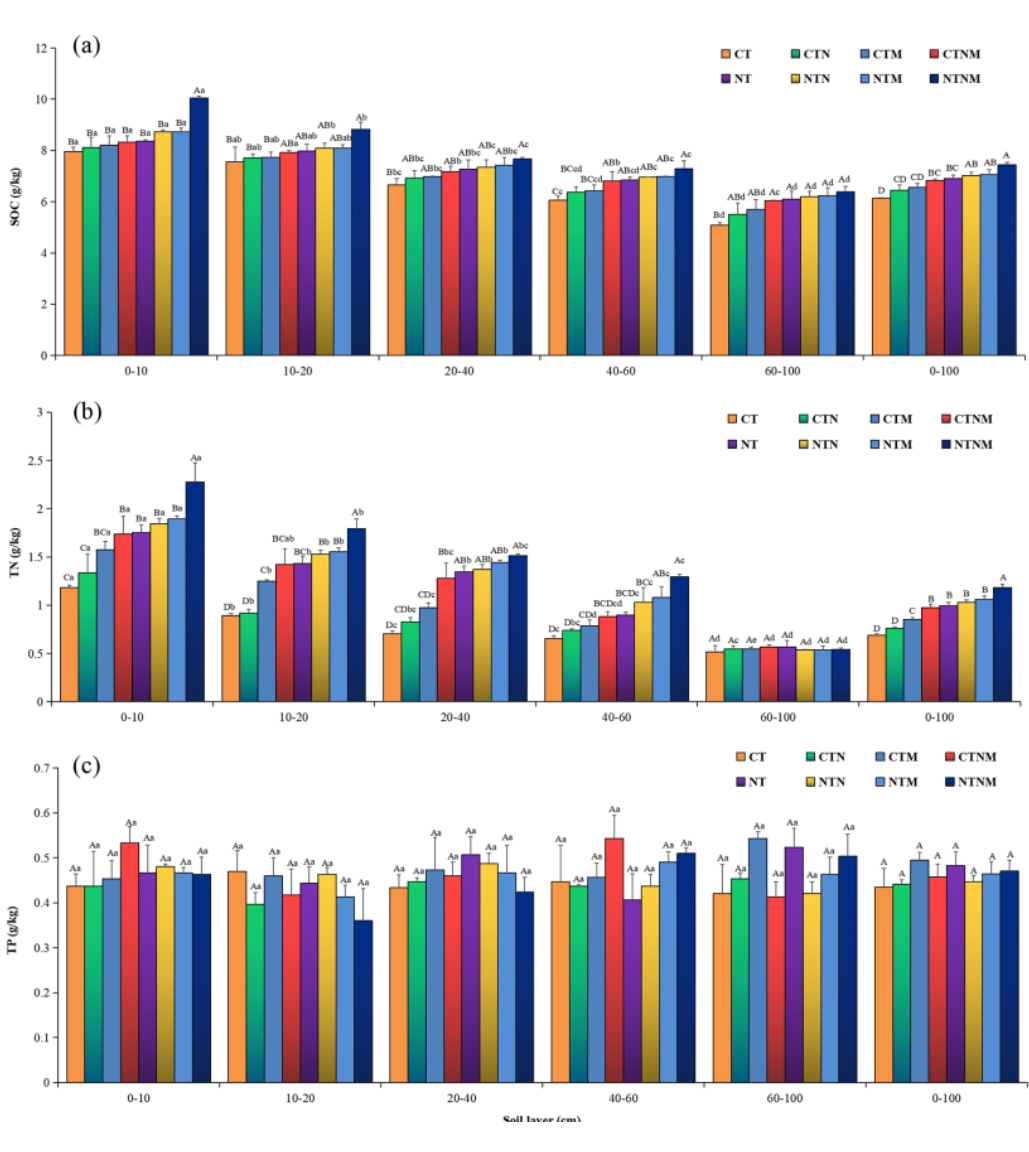
Figure 3. Effect of tillage techniques and N fertilization methods on soil quality indicators. Note: ( a ) is the concentration of SOC at different soil layers, ( b ) is the concentration of TN at different soil layers, and ( c ) is the concentration of TP at different soil layers. The error bars indicate standard deviation. Different capital letters indicate significant differences between different treatments for the same soil layer ( p < 0.05; Duncan’s test), and different lower-case letters indicate significant differences between different treatments and different soil depths ( p < 0.05; Duncan’s test). CT: conventional tillage, CTN: conventional tillage with inorganic N fertilizer, CTM: conventional tillage with organic N fertilizer, CTNM: conventional tillage with combined application of organic and inorganic N fertilizer, NT: no-tillage, NTN: no-tillage with inorganic N fertilizer, NTM: no-tillage with organic N fertilizer, NTNM: no-tillage with combined application of organic and inorganic N